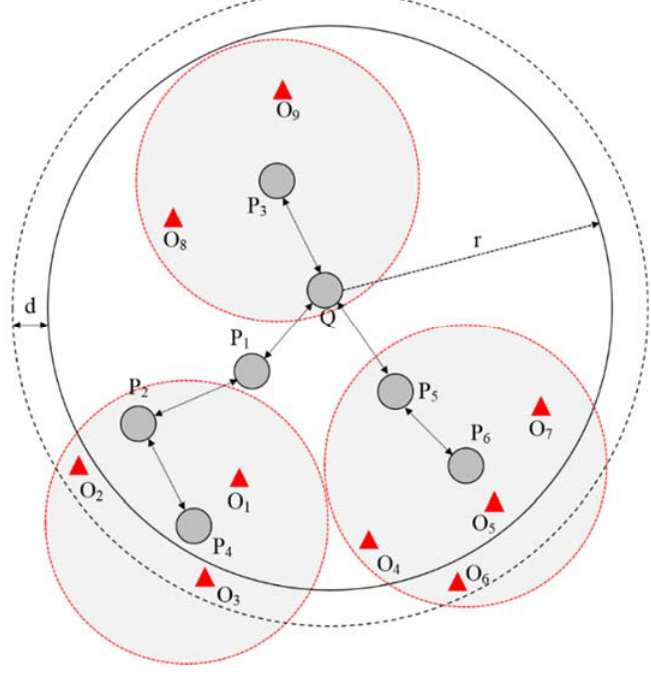
Figure 1. Proposed query ‐ processing environment.